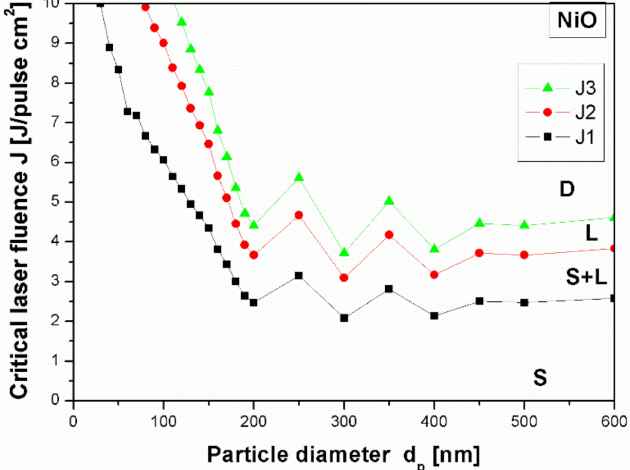
Figure 4. Theoretically calculated dependence of critical laser fluence on NiO particle diameter for different processes taking place during irradiation: the beginning of particle melting (J1), entire melting (J2), the decomposition (J3) (laser wavelength 532 nm). The capital letters S, S+L, L, D label regions of solid phase, mixture of solid and liquid phase, liquid phase and phase after decomposition,